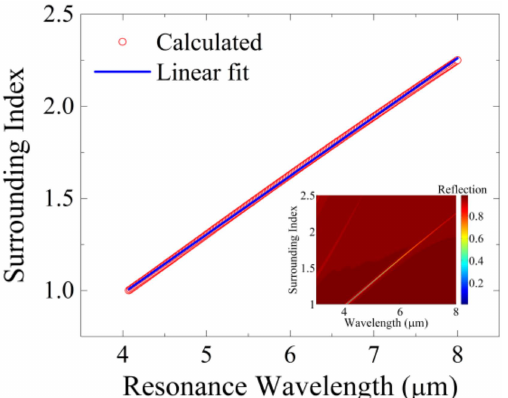
Figure 7. Resonance wavelength (red circle) versus refractive index of the surrounding. A linear fit (blue line) is also shown. Inset shows the associated reflection map.